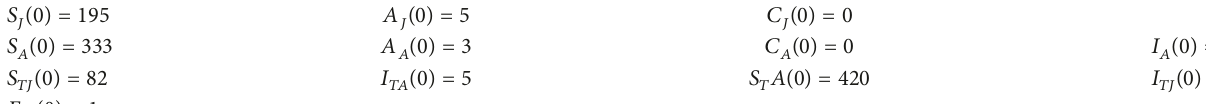
Table 3: Initial conditions used for the simulations of model (12) for the three control strategies.